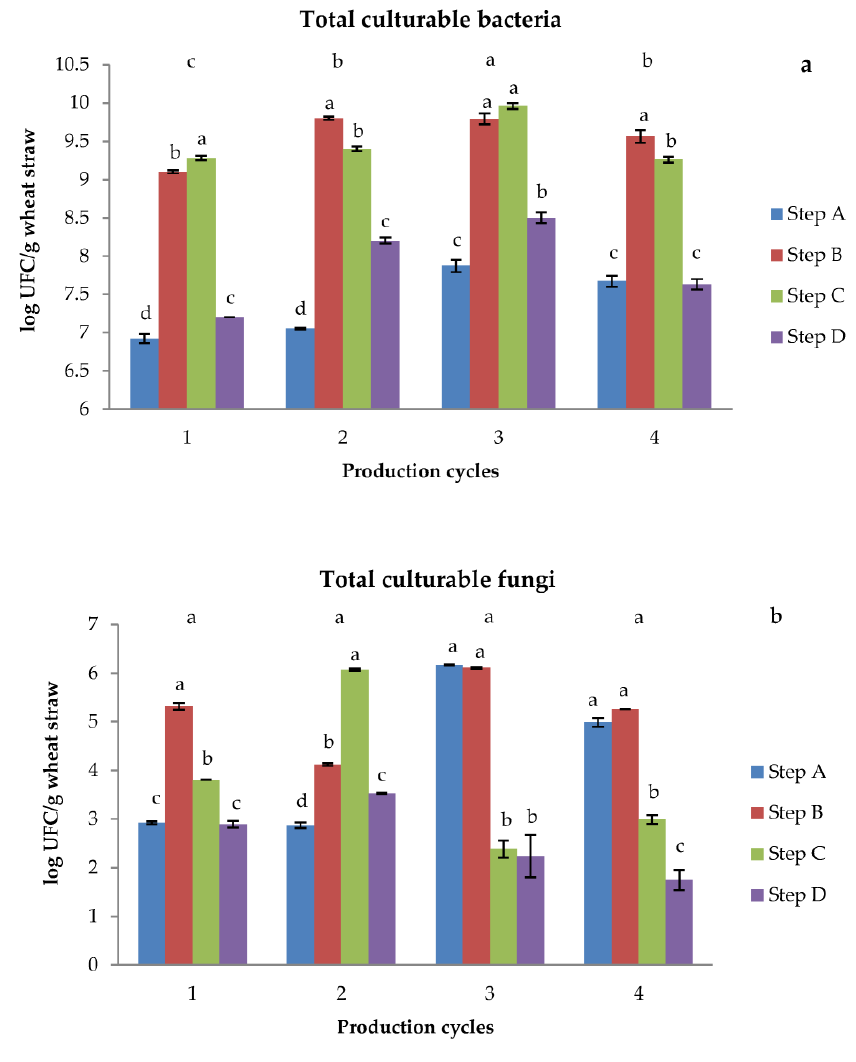
Figure 3. Total culturable bacteria ( a ) and fungi ( b ) expressed as log UFC g −1 substrate. Different letters above production cycles indicate significant ( p < 0.05) differences among them. Different letters above each bar indicate significant ( p < 0.05) differences among steps of the same production cycle.